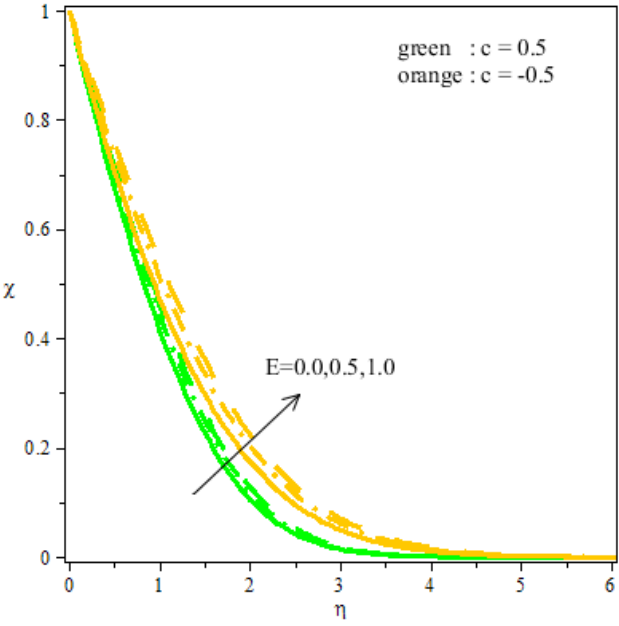
Figure 15. The curve χ ( η ) on E